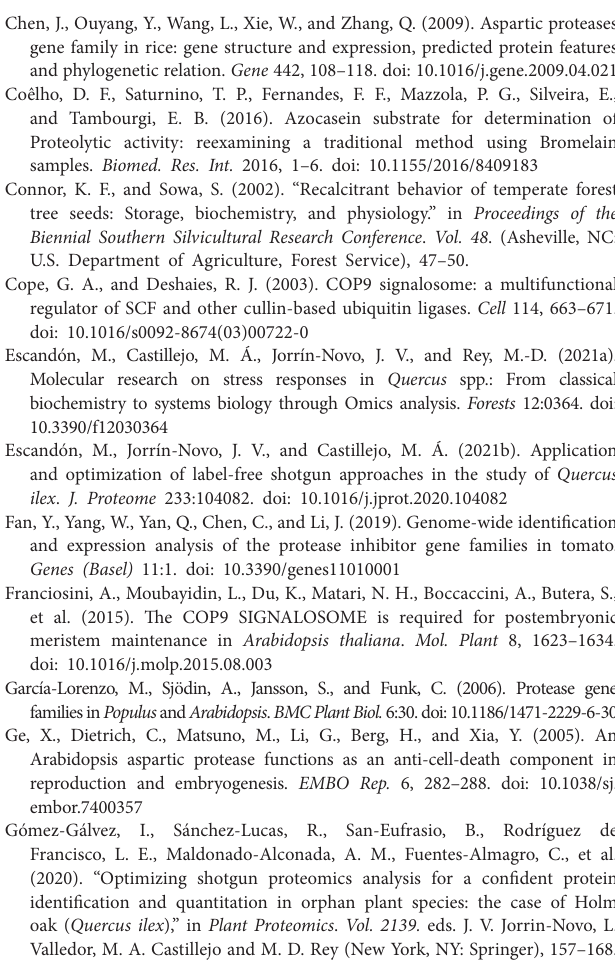
Supplementary Figure S1 | Germination stages. T1: mature acorns prior to germination. T2, T3, T4: Germinated acorns when root tips were visibly emerging from the cotyledons (T2), their size reached 6.5 mm (T3) and it exceeded 20 mm (T4). The bar corresponds to 1 cm. Supplementary Figure S2 | Classification of germination stages from a PCA plot of shotgun data. The PCA encompassed all proteins. E, embryo axis. C, cotyledon. NV: Nongerminated acorns after 4 weeks of germination. T1: mature acorns prior to germination. T3: germinated acorns when root tip size reached 6.5